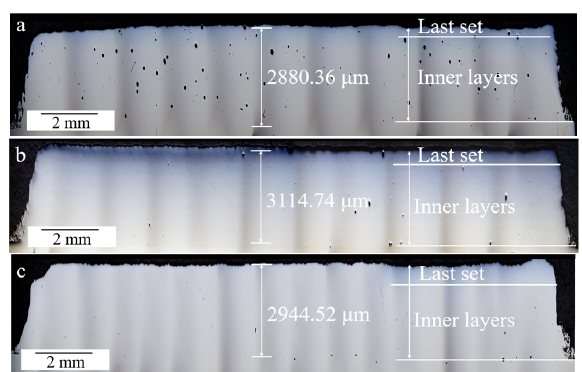
Figure 11. OM photographs of cross-sections built up by strategy ( a ) one single layer as a set; ( b ) three layers as a set; ( c ) five layers as a set.